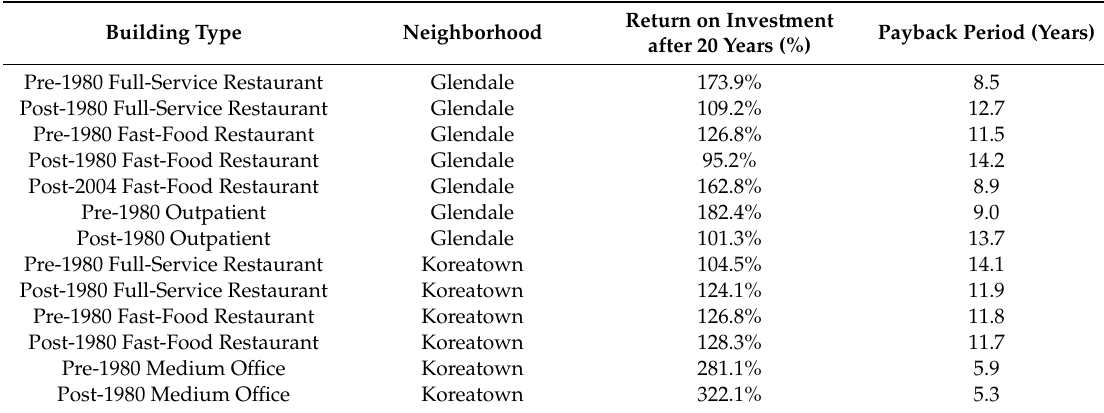
Table 7. Return on investment (%) and payback periods (years) for installing green roofs and photovoltaic systems on all tested